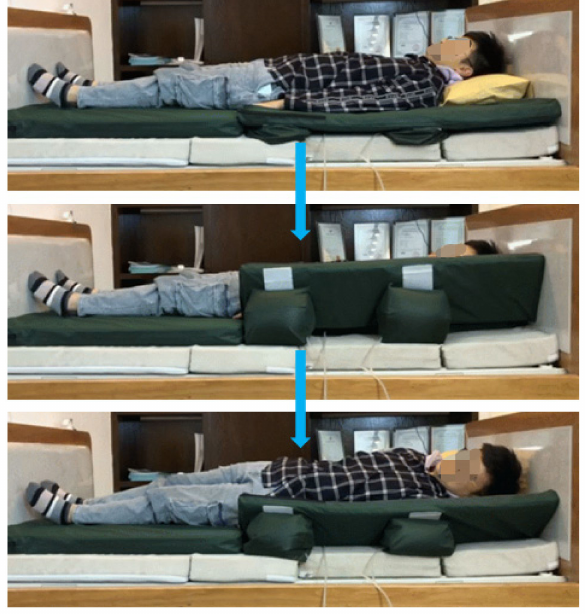
Figure 14. Three steps in the process of